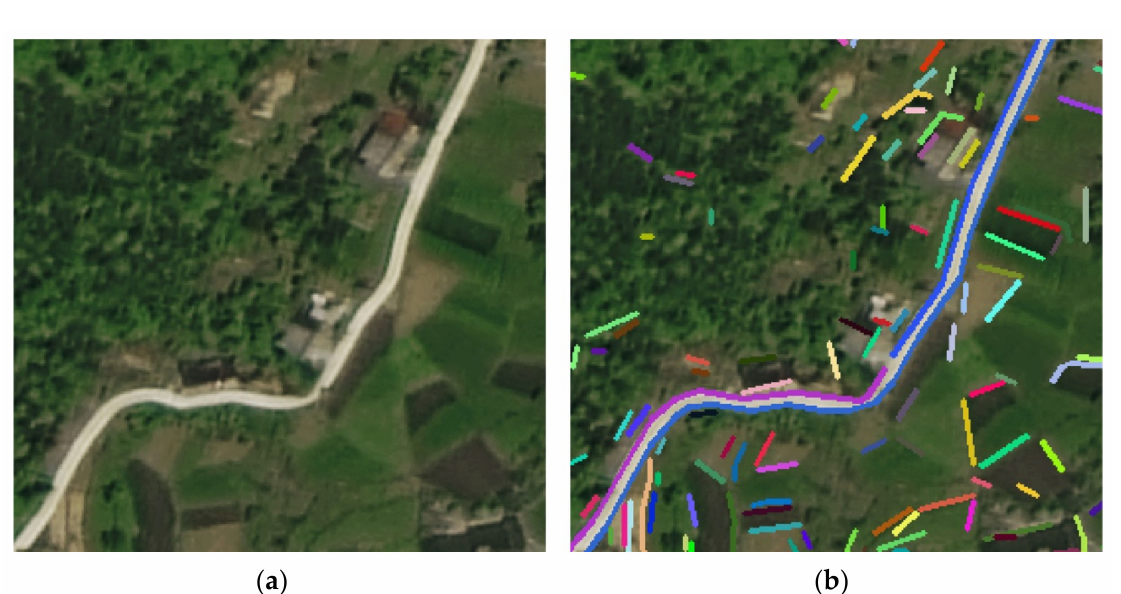
Figure 2. Extraction of line segment sequence. ( a ) The original image. ( b ) Result of line segment